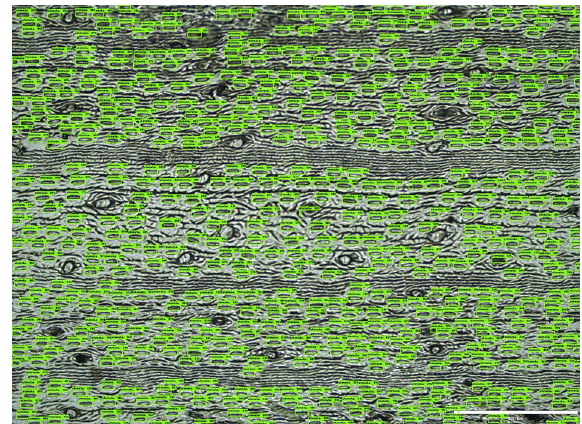
Figure 5. Stomata detection on entire microscopic image. The detected stomata were labelled in green bounding boxes together with a detection score on